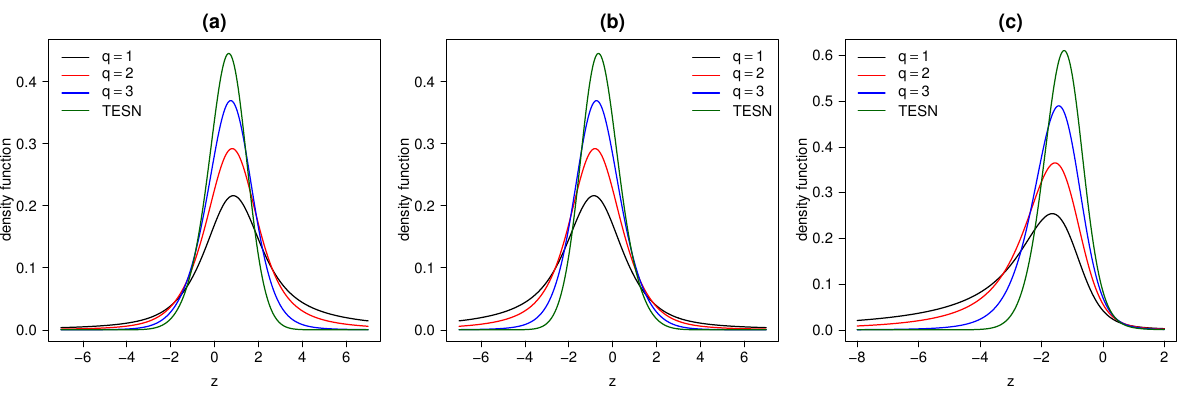
Figure 2. STESN for values of ( a ) λ = − 2; ( b ) λ = 2; and ( c ) λ = 7 for different values of q